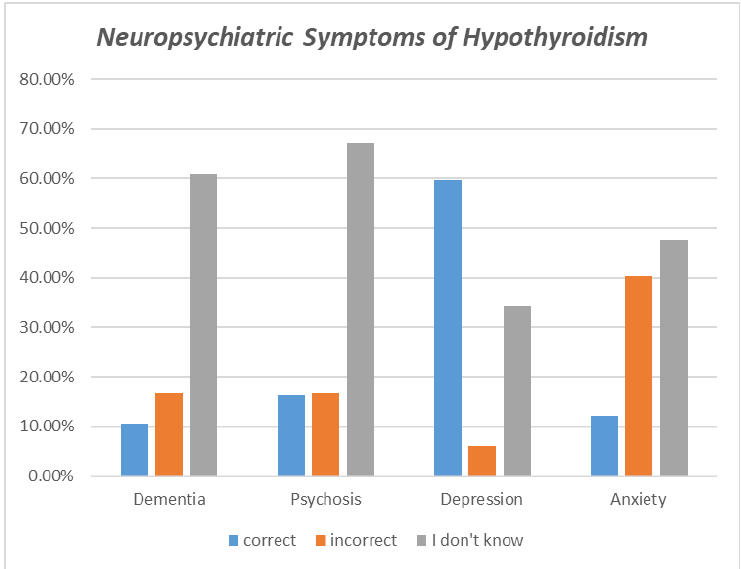
Figure 2. Neuropsychiatric symptoms of hypothyroidism.